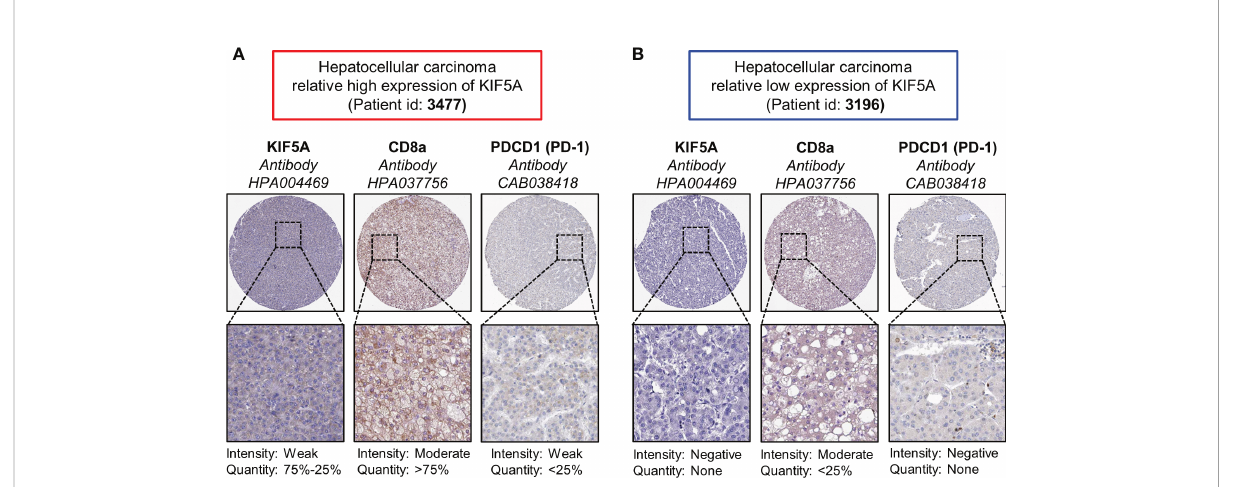
FIGURE 8 Associations between KIF5A with CD8a and PD-1 in LIHC. (A) Representative IHC staining pictures of LIHC with relative high expression of KIF5A. (B) Representative IHC staining pictures of LIHC with relative low expression of